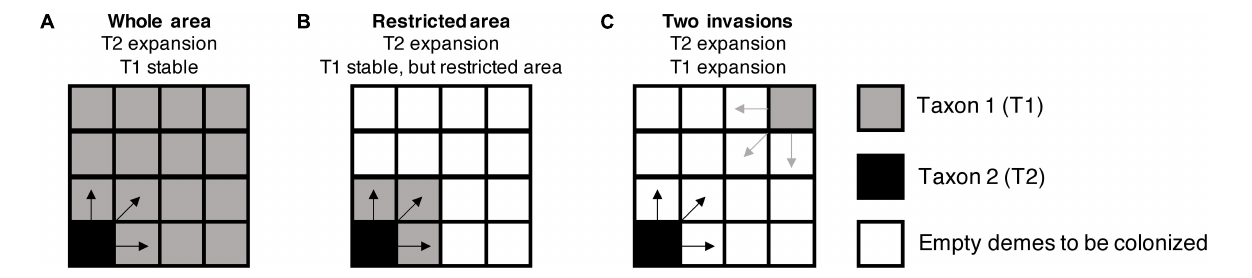
FIGURE 1 | Schematic representation of simulated scenarios of biological invasion and hybridization between two taxa. The “whole area” scenario (A) : one taxon (T1) is already present in the whole area and is considered local, whereas a second taxon (T2) arrives with few individuals and starts an invasive range expansion from a corner of the distribution range of T1. The “restricted area” scenario (B) : similar to the previous scenario, but the local taxon (T1) is distributed in a more restricted area (25% of the total area). The “two invasions” scenario (C) : both taxa are invasive and start a range expansion from opposite corners of the simulated area. Empty demes are suitable to be colonized by both taxa in this last